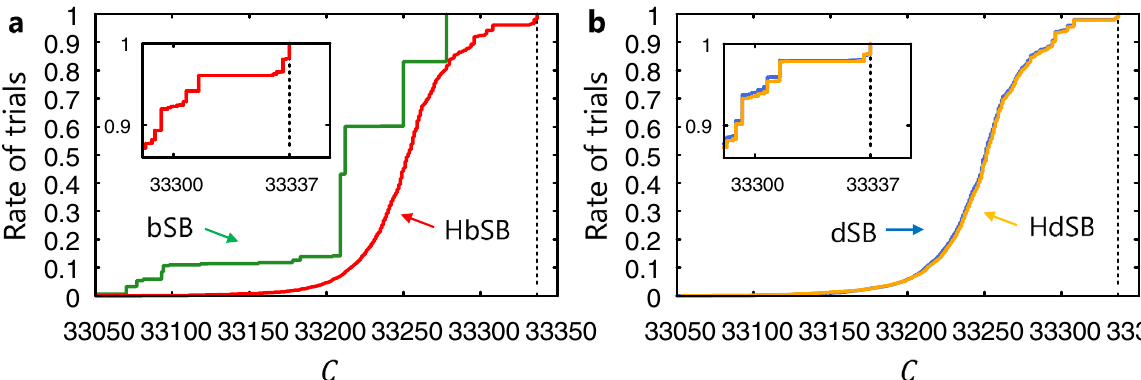
Fig. 2 Cumulative distributions of cut values C for K 2000 . a For bSB and HbSB. b For dSB and HdSB. (SB means simulated bifurcation, and b, d, and H denote ballistic, discrete, and heated, respectively.) The dashed vertical line indicates the best known cut value 33337. Insets show magni fi cations around the best known cut value. Here the number of time steps is N s = 10000, and parameters Δ t , c 1 , and γ are the same as in Fig.